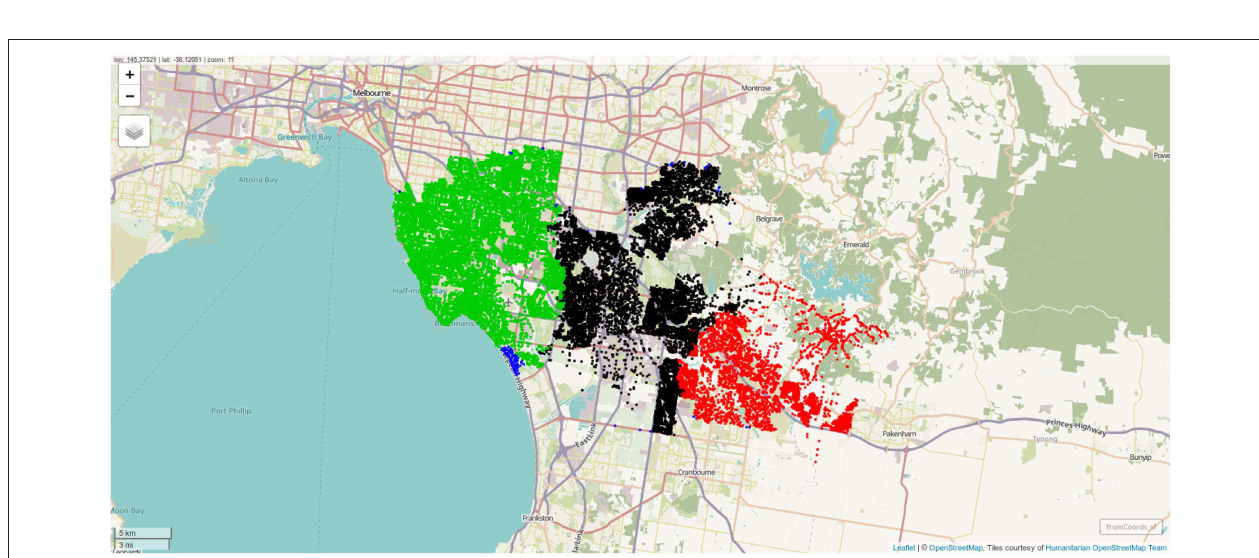
FIGURE 6 | Sampled address colorcoded according to nearest destination, with distance to destination computed through the street network. Screenshot of interactive visualization created with mapview .